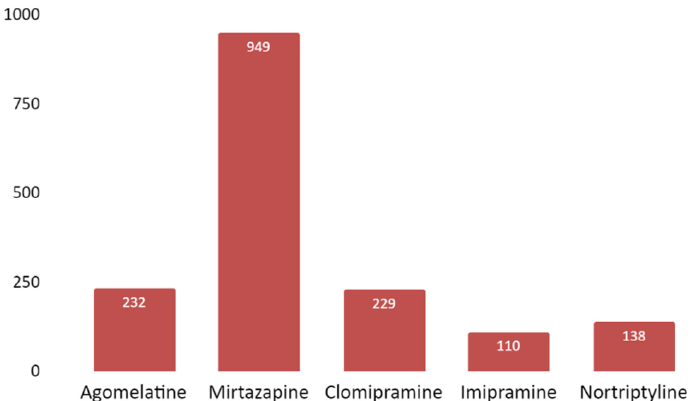
Figure 8. Number of tweets ( Y -axis) per studied antidepressant ( X -axis) (including both active ingredient and commercial name). Only antidepressants that were mentioned in at least 100 tweets are shown in the figure.